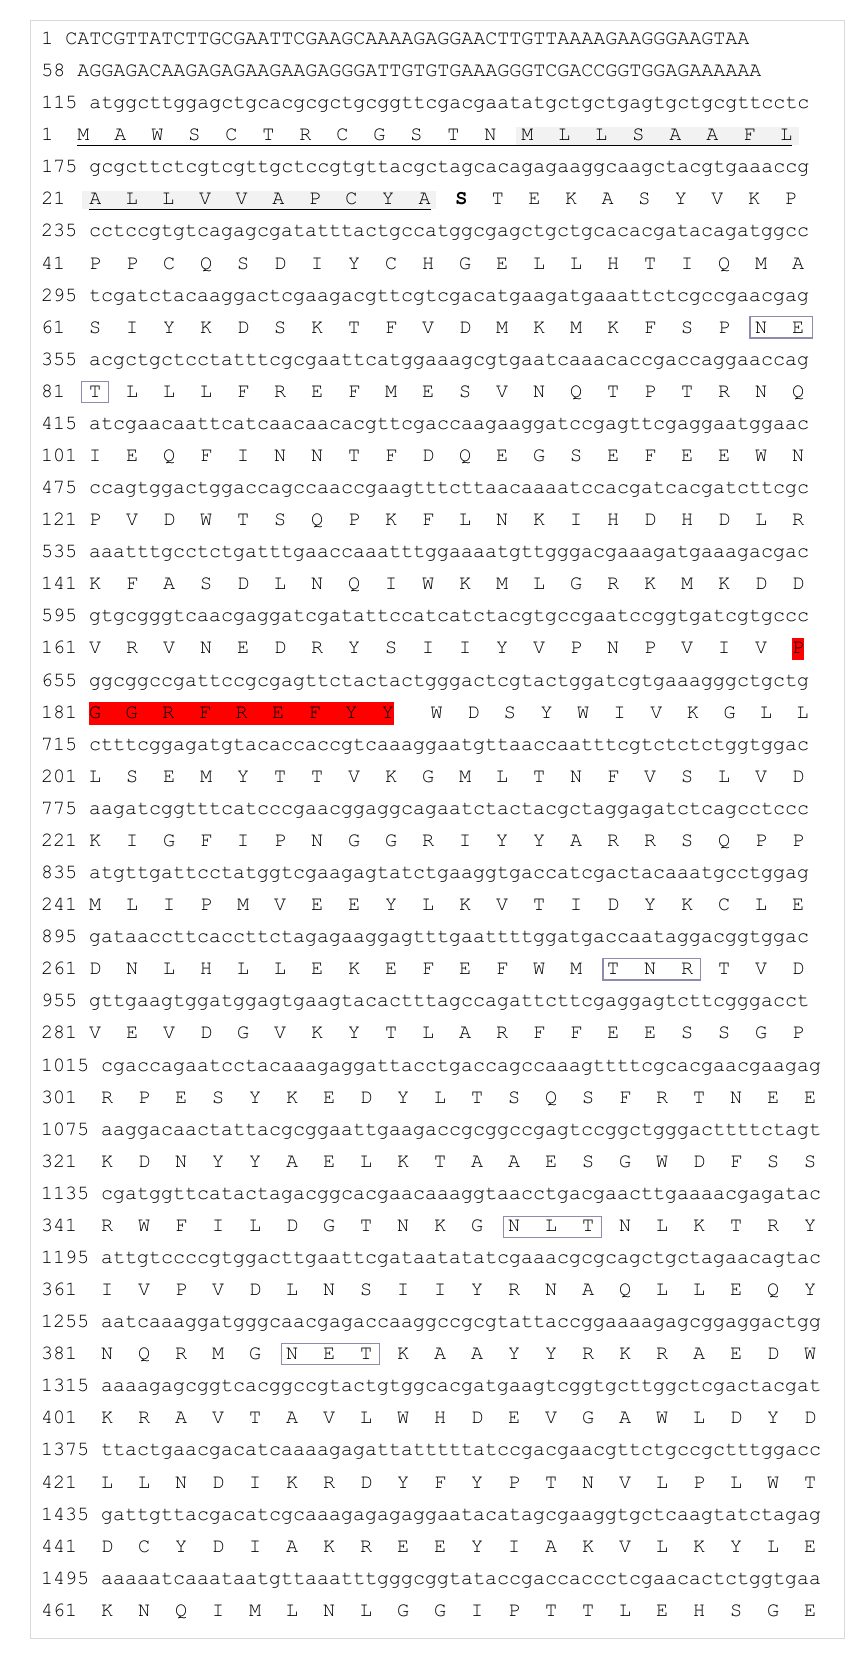
Fig 1 . Nucleotide and deduced amino acid sequences of BlTre-2 . The numbers on the left are the positions of nucleotides and amino acids in the sequences; underlined amino acid residues represent the signal peptide; the cleavage site is indicated by an arrow; the N-glycosylation sites are indicated by a box; the highly conserved glycine-rich region is shaded gray and the trehalase signature motif is shaded red; transmembrane domains are gray and